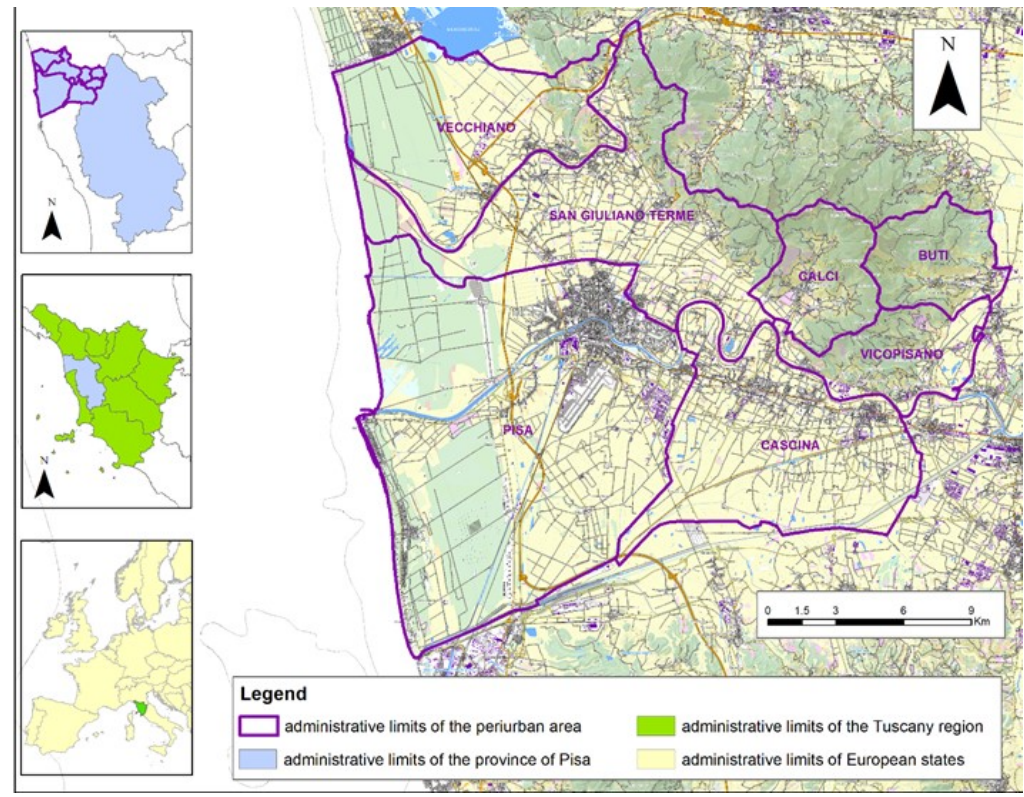
Figure 1. The case study in the peri-urban area of Pisa (Italy).